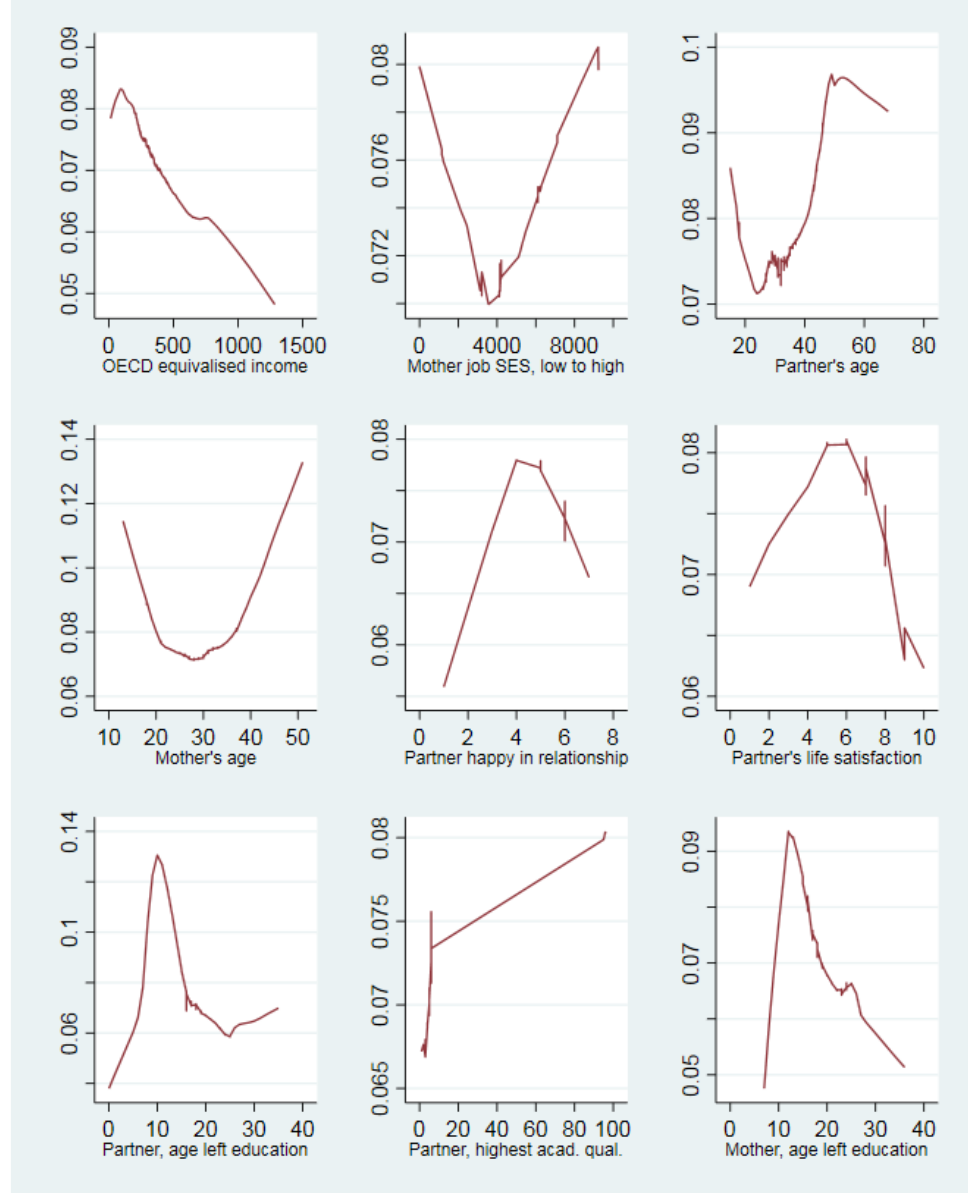
Figure 4. Scatter plots with lowess-smoothed trend lines showing relationships between the proportion of infants prematurely born before 37 weeks (y-axis), and the nine predictors in the RF algorithms with the highest feature importance scores. SES by job (SOC2000) and academic qualifications are coded from high to low, and relationship and life satisfaction are coded from low to high satisfaction. Data points are hidden to avoid visual confusion and show the trends clearly.